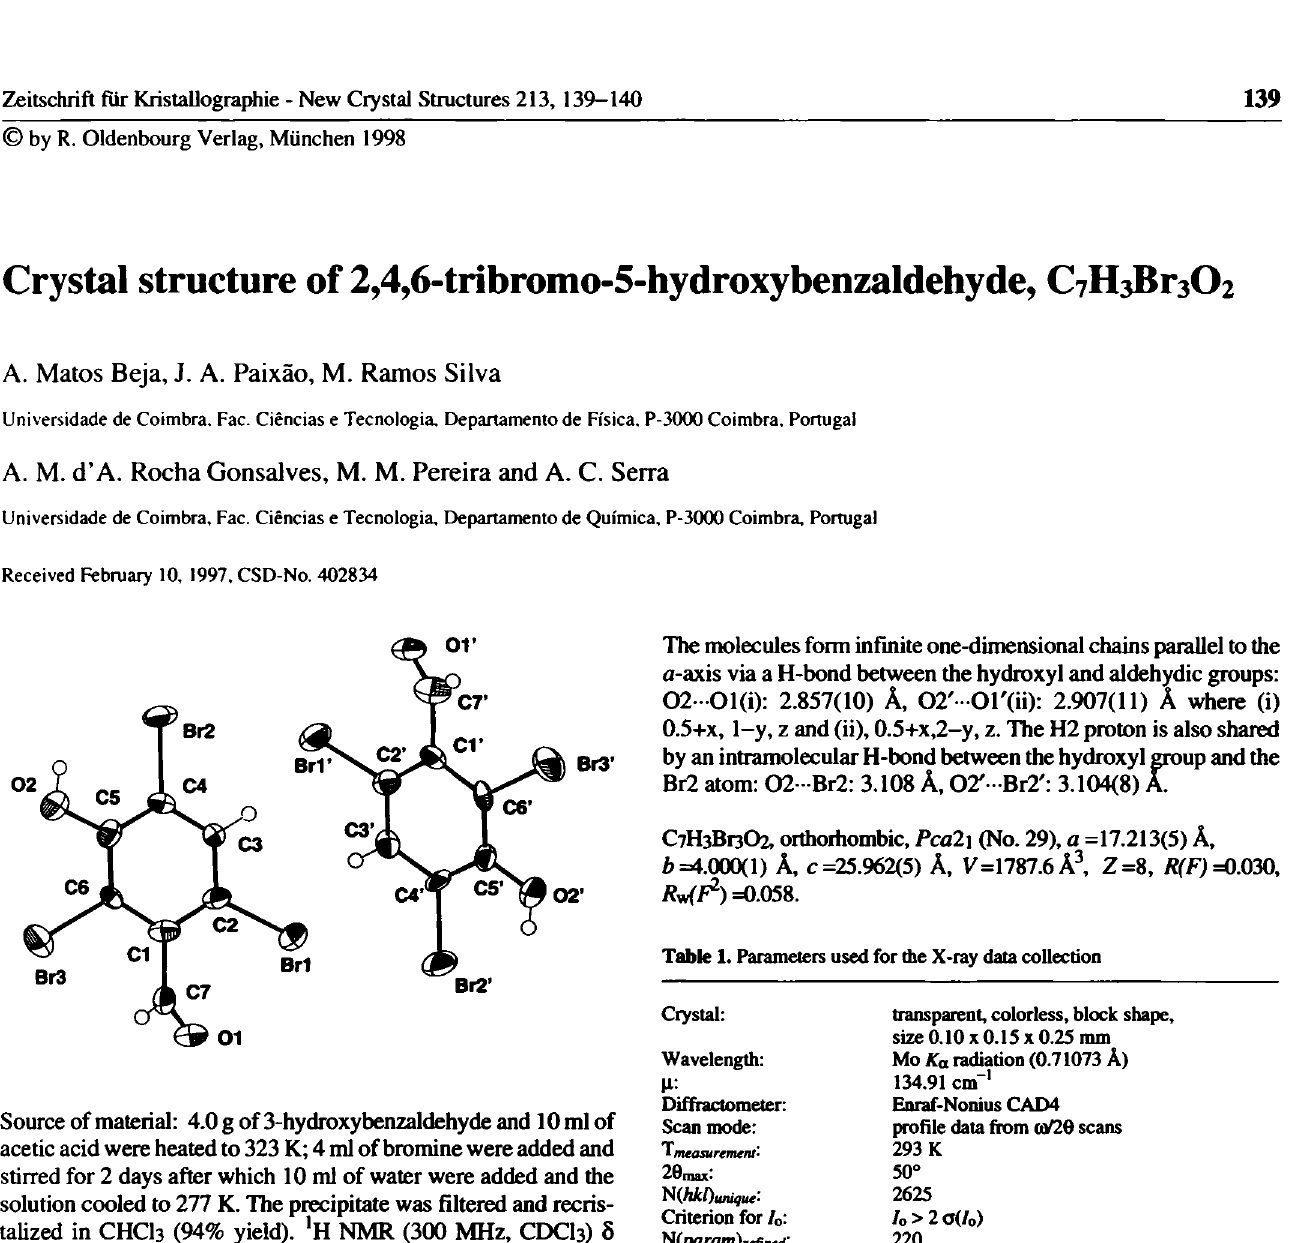
Table 2. Final atomic coordinates and displacement parameters (in